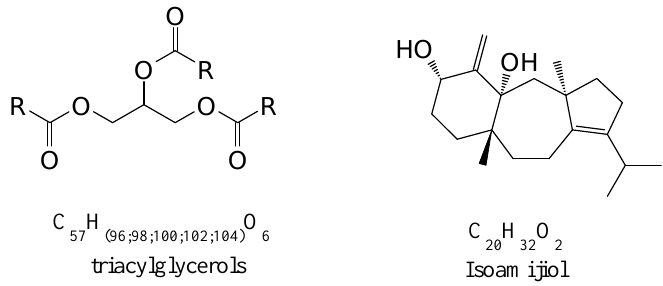
Figure 2. Chemical structures of most abundant compounds analyzed by UHPLC-ESI(+)-HRMS. Long-chain triacylglycerols were identified in the extracts, among which triacylglycerol 54:5 was the most abundant. In the group of fatty acid derivatives, oleamide, an amide of oleic acid, was the most abundant. In vivo studies suggested that oleamide exhibits significant anti-inflammatory activity and can contribute to the prevention of Alzheimer’s disease